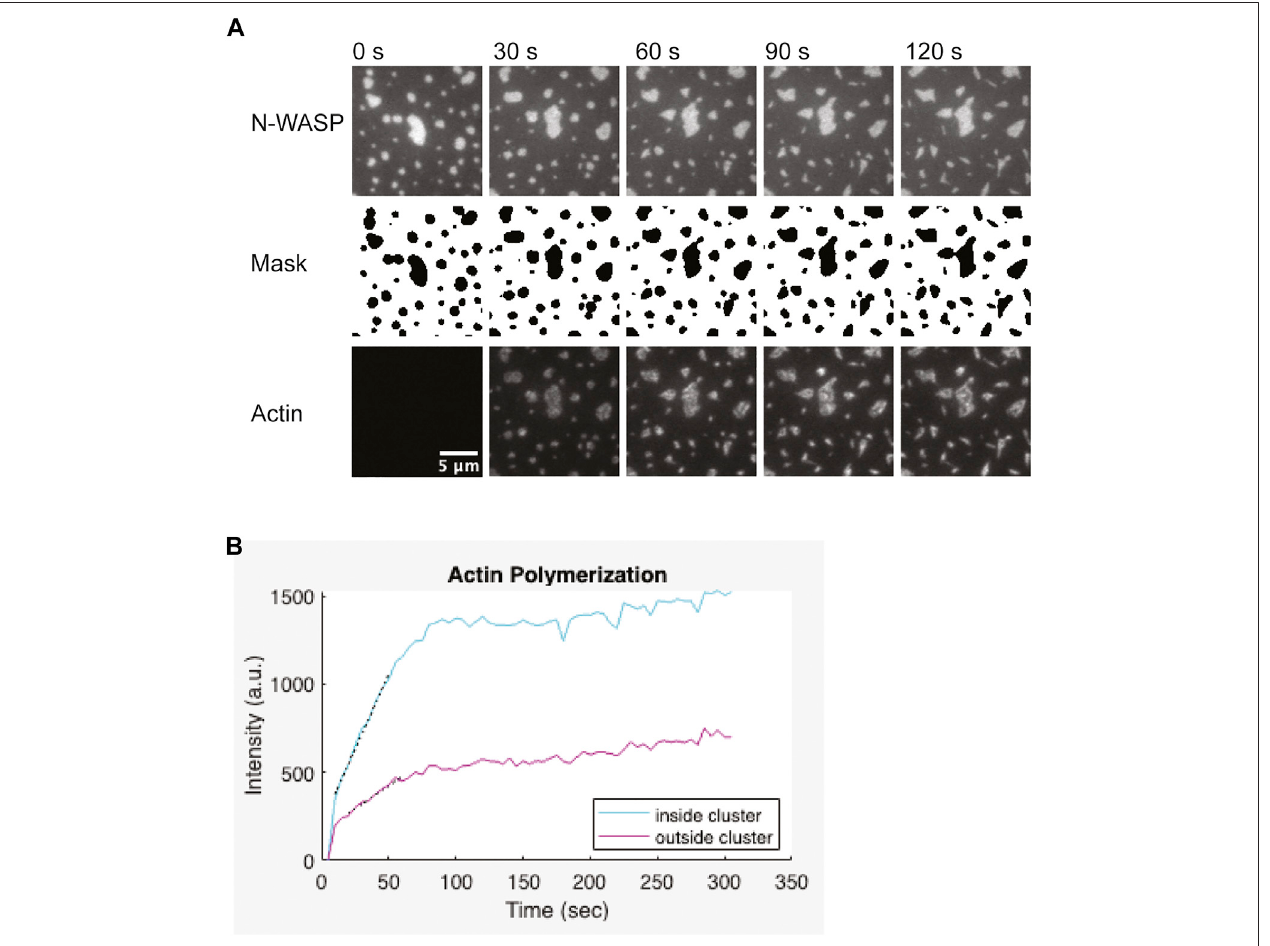
FIGURE6 | Representative actin polymerization analysis (A) 1 µM actin (5% labeled byAlexa647) polymerizationis induced by3 nM Arp2/3, 6 nM CapZ, 0.25 µM ATP, 0.1 mM MgCl 2 and 0.1 mM EGTA, from clustersmade from 1 µM Nck, 2 μ M N-WASP (15% Alexa488) and 1.25 nM His 8 -nephrin on the membrane. Binary mask from segmentation of the N-WASP images. Pixels outside the clusters are white, pixels inside the clusters are black. Scale bar, 5 µm. (B) Quanti fi cation of actin polymerization over time for the condition showed in A. Graph was generated in Matlab. Black dotted lines indicate a linear fi tof the fi ve points around the half-max